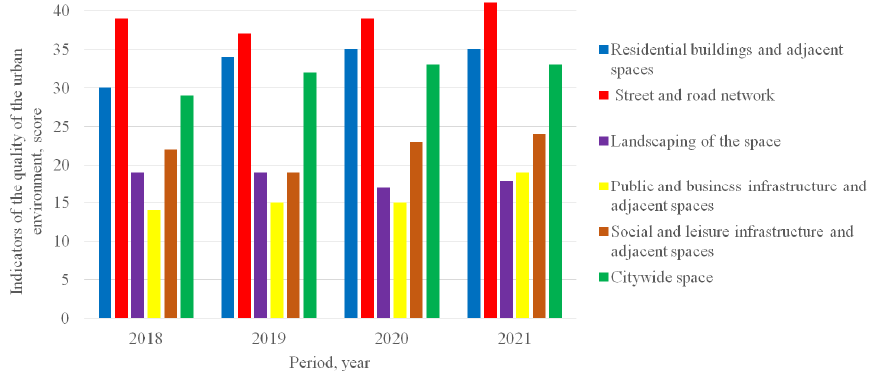
Figure 5. Indicators of the quality of the urban environment in the city of Pallasovka, Volgograd Oblast, Russia.